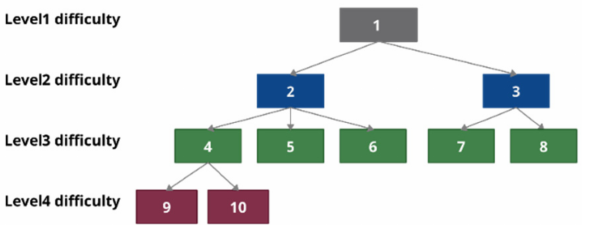
Figure 8. The second example of competence tree, used for transformation to graph-based solutions.